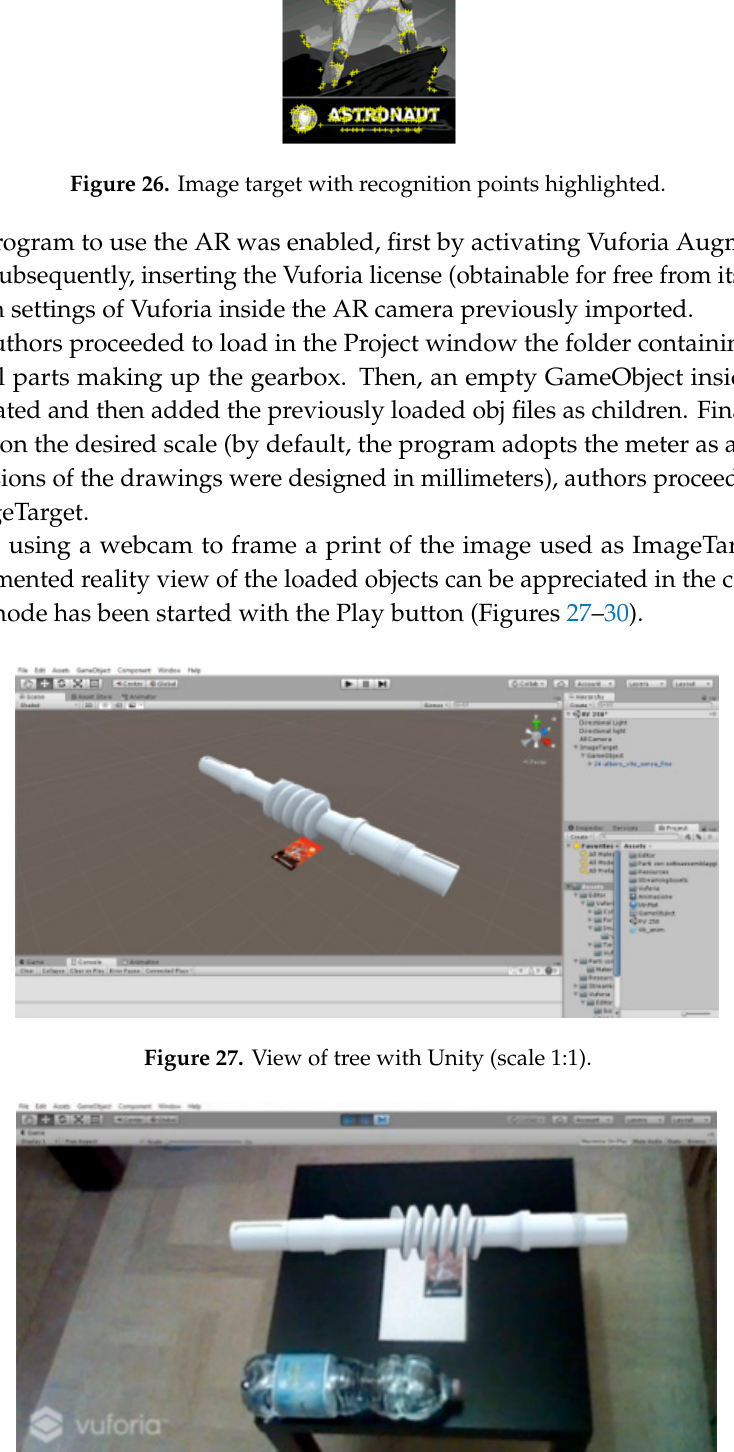
Figure 25. Image target (used dimensions: 512 × 885).